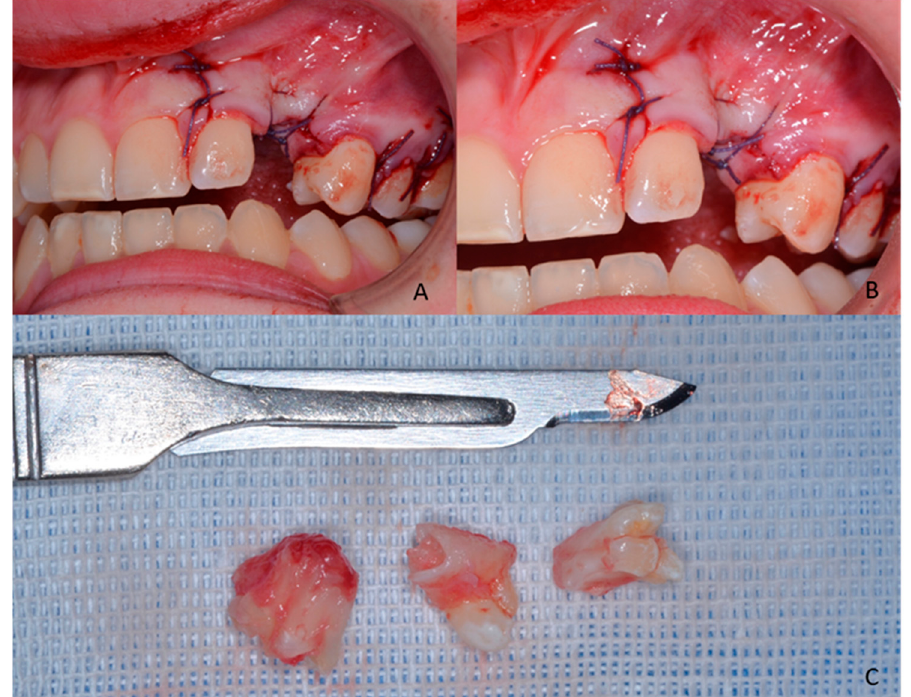
Figure 4. ( A , B ) Suture of the flap (Vicryl Ethicon 3.0, 17 mm 1/2c, Johnson & Johnson International, Hamburg, Germany); ( C ) clinical aspect of the odontoma, (Bard-Parker stainless steel size 15, Benefits srl, Genova, Italy). ( A , B ) The suture is visible at the level of the relief incision in the ridge; ( C ) various fragments of the removed odontoma are recognizable, the neoformation is organized in variously cusped denticles. The structures of the compound odontoma with crowns and roots are recognizable.